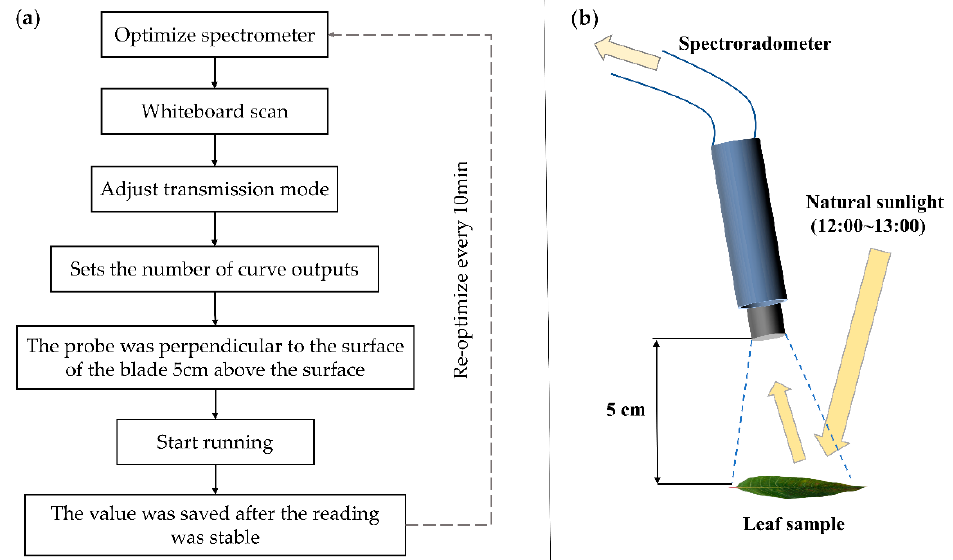
Figure 2. The operation flow of ASD spectrometer for measuring leaf surface spectrum. ( a ) is the operation flow of ASD spectrometer. ( b ) is a schematic diagram of the operation of the spectrometry of the blade.